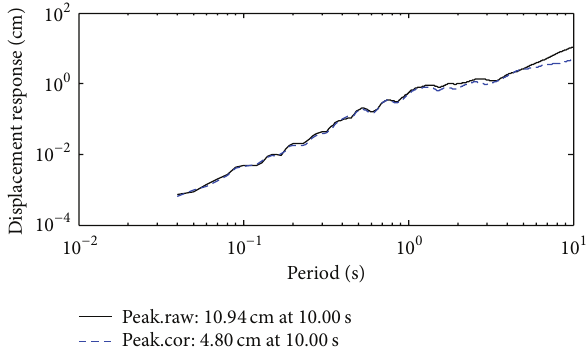
Period (s) Peak.raw: 29.81 cm/s 2 at 0.51 s Figure 21: Absolute acceleration response spectrum.